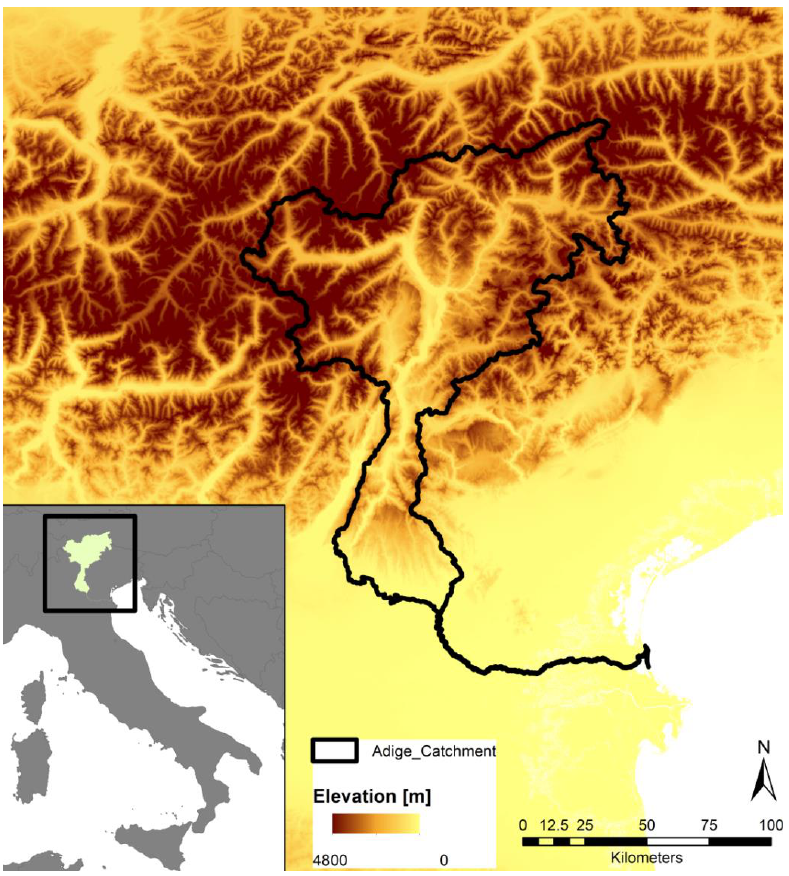
Figure 1. Location of the Adige catchment and corresponding elevation.